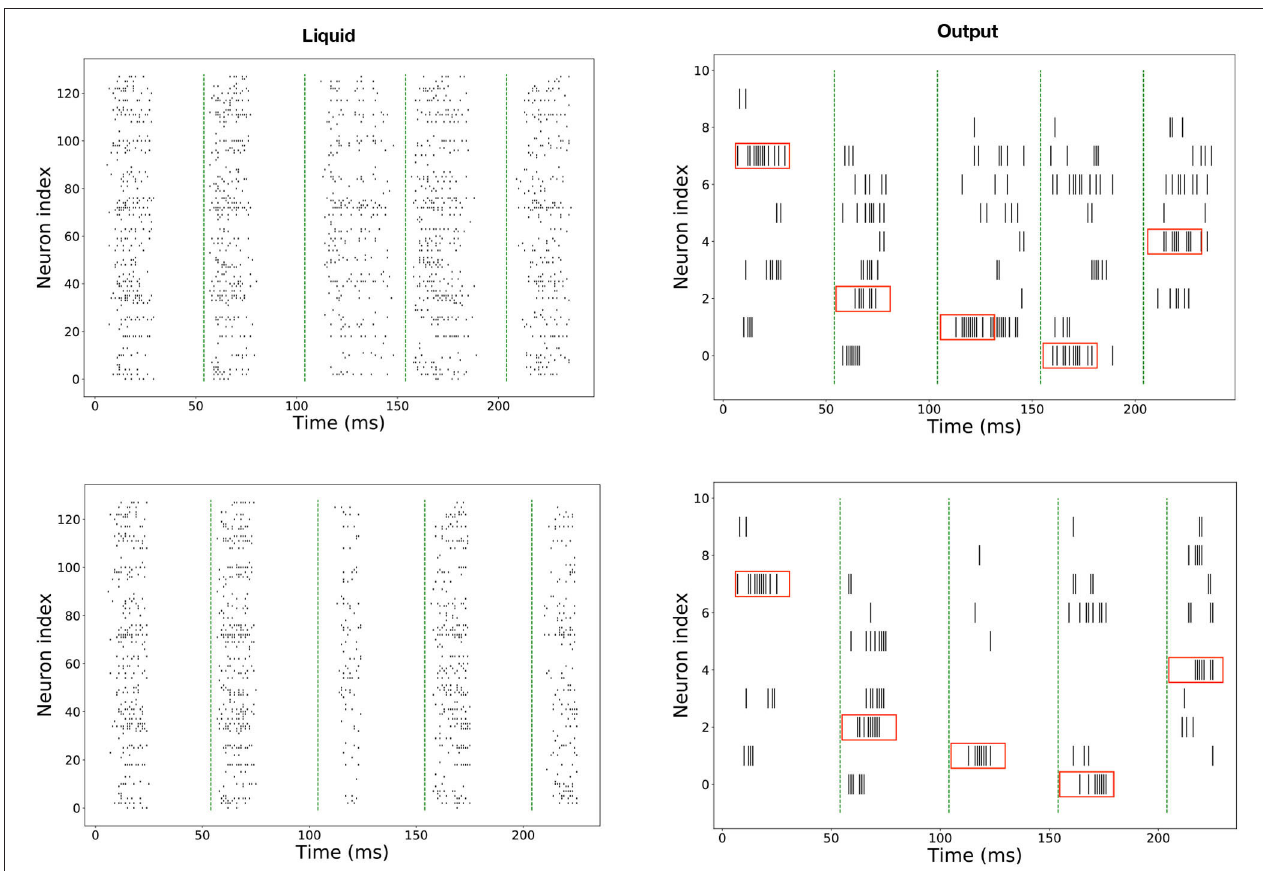
FIGURE 6 | Spiking response in SpiNNaker for five sequential inputs, corresponding to the digits 7, 3, 2, 1, 4. Top: Without a rhythmic inhibitory population. Bottom: With a rhythmic inhibitory population attached to the liquid population. The red boxes in the readout indicate the expected response, and the green dashed lines mark the start of new